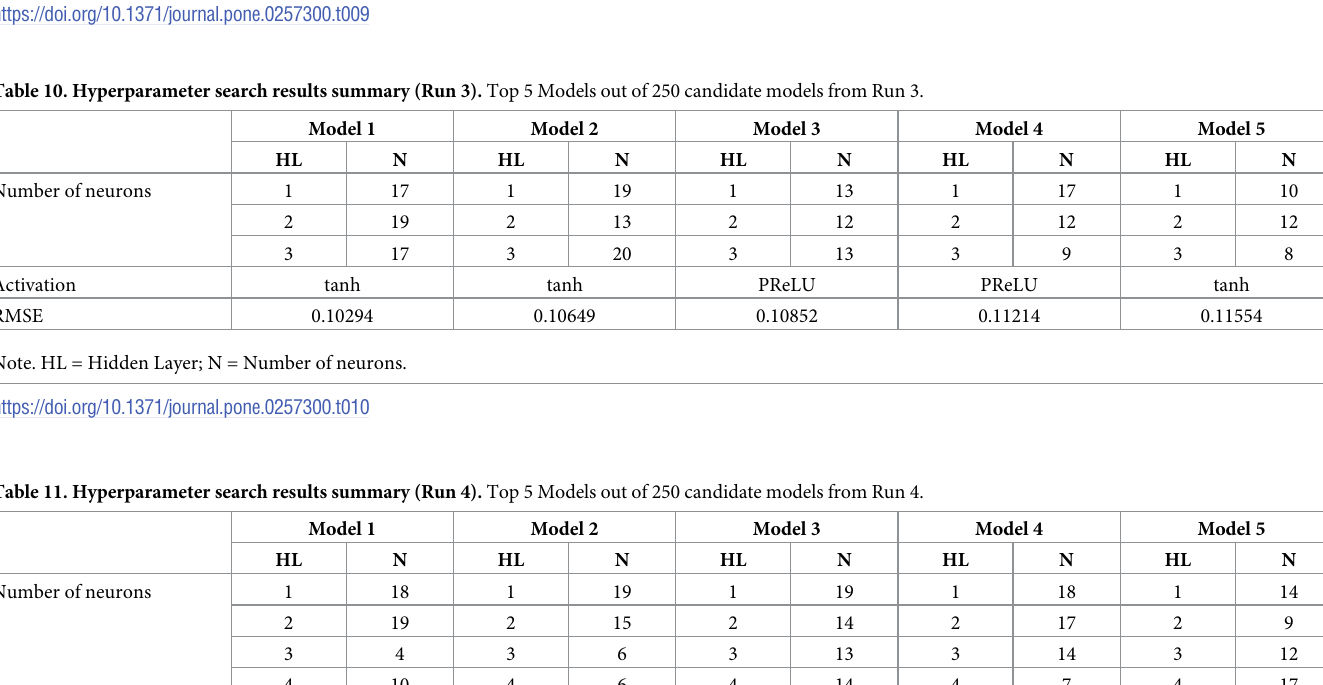
Number of neurons